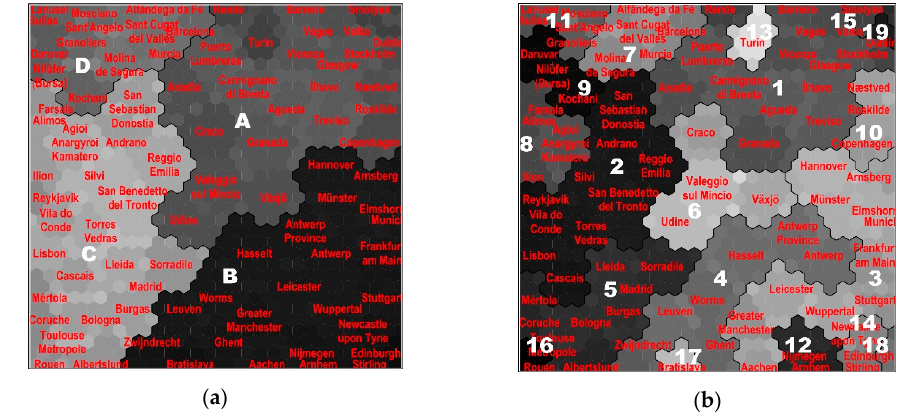
Figure 6. Maps of Mayors Adapt (MA) adaptation strategies. Obtained by means of Self-Organizing Maps (SOM). You can see in both figures the same location in the map of each municipal strategy. According to the operation of the SOMs, the closer the map is, the greater the similarity of the input variables. Two different classifications are shown: ( a ) classification in four main clusters or Patterns; ( b ) classification in 19 clusters or Profiles. Source: Compiled by the authors.